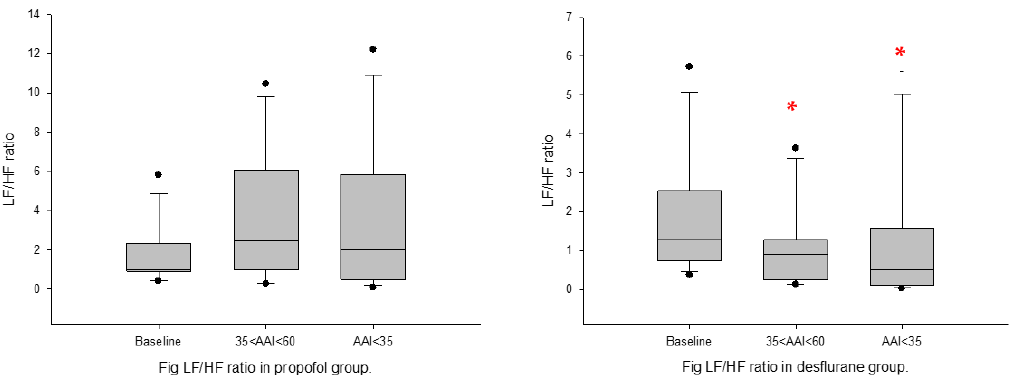
Figure 3. LF/HF ratio at baseline and post-general anesthesia for Group P (propofol); Group D (desflurane). Box plots show the median, 10th, 25th, 75th, and 90th percentiles as vertical boxes with error bars and plot all data points that lie outside the 10th and 90th percentiles as black circle dots. The significance levels with paired t -tests between baseline and successive measurement periods are as follows: * p <